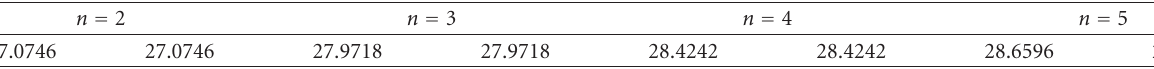
Table 1: Modal frequencies ω o n , l in rad/s, relevant to the perfect rotor and evaluated according to the EB model. Modal frequencies relevant to modal numbers n = 2 · · · 5 and l = 1.